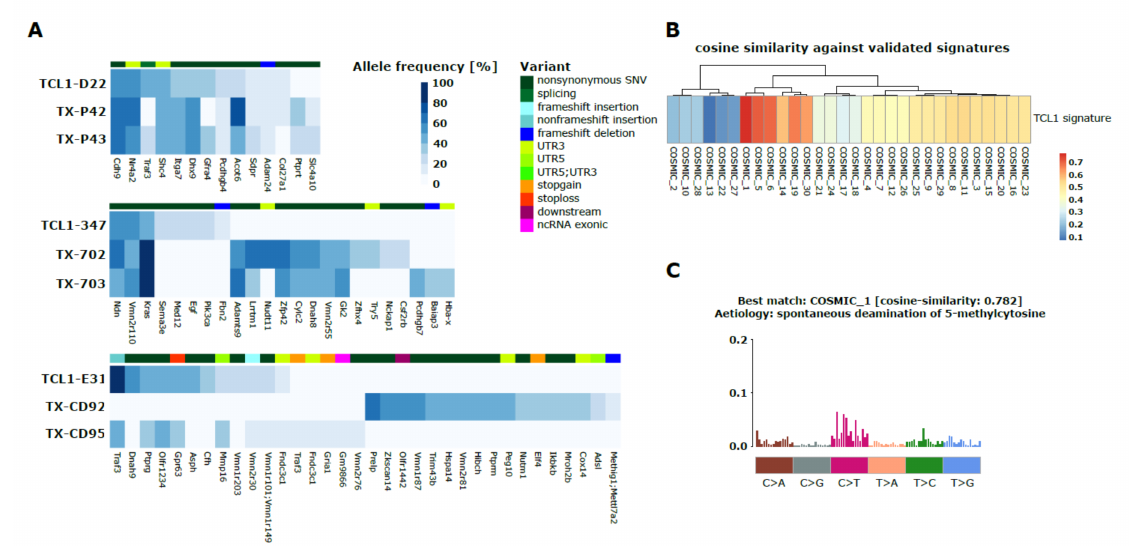
Figure 1. Somatic mutations and mutational signature in TCL1 transgenic mice (TCL1) and congenic recipient mice (TCL1 Tx). ( A ) Heatmaps of somatic mutations found by WES of splenic CLL cells of three TCL1 tumor lines (D22, 347, E31) [10] each transplanted into 2 congenic recipient mice (TCL1 Tx). Color scheme corresponds to allele frequencies of mutations.